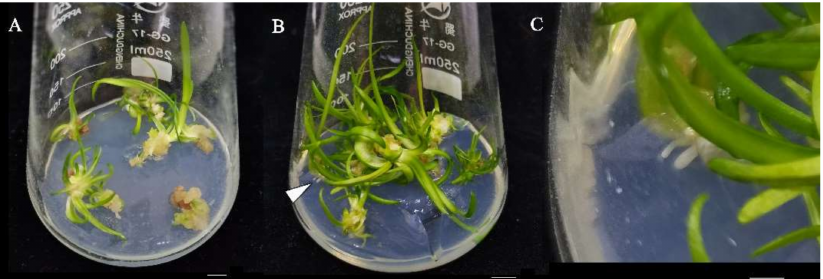
Figure 6. Plantlets regeneration from calluses of A. praecox root tips after 25 days and 90 days in organogenesis medium. ( A ) Adventitious bud after 25 days of differentiation. Bars = 1 cm; ( B ) plantlets after 90 days of differentiation. Bars = 1 cm; ( C ) adventitious root indicated by ar- rows in ( B ). Bars = 0.2 cm.